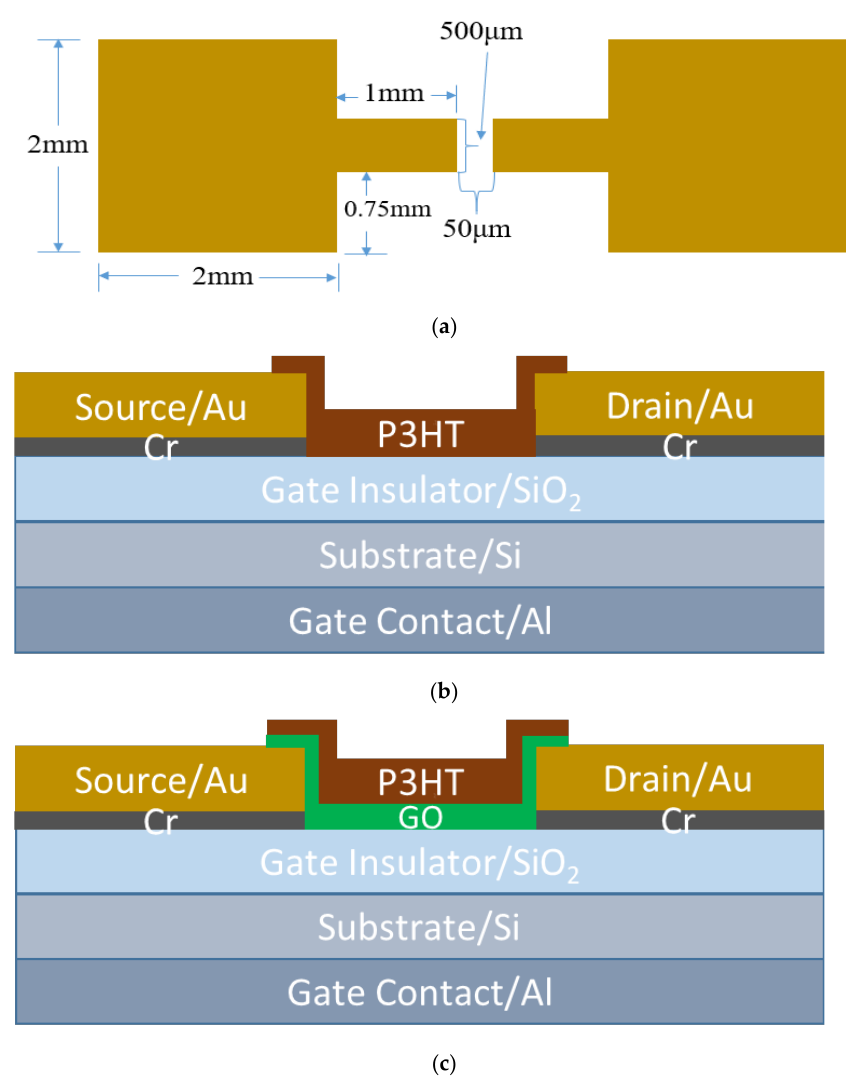
Figure 1. ( a ) Top view of the source and drain contacts with their dimensions; ( b ) Schematic struc- ture of P3HT-based S-OTFT; ( c ) Schematic structure of P3HT-based